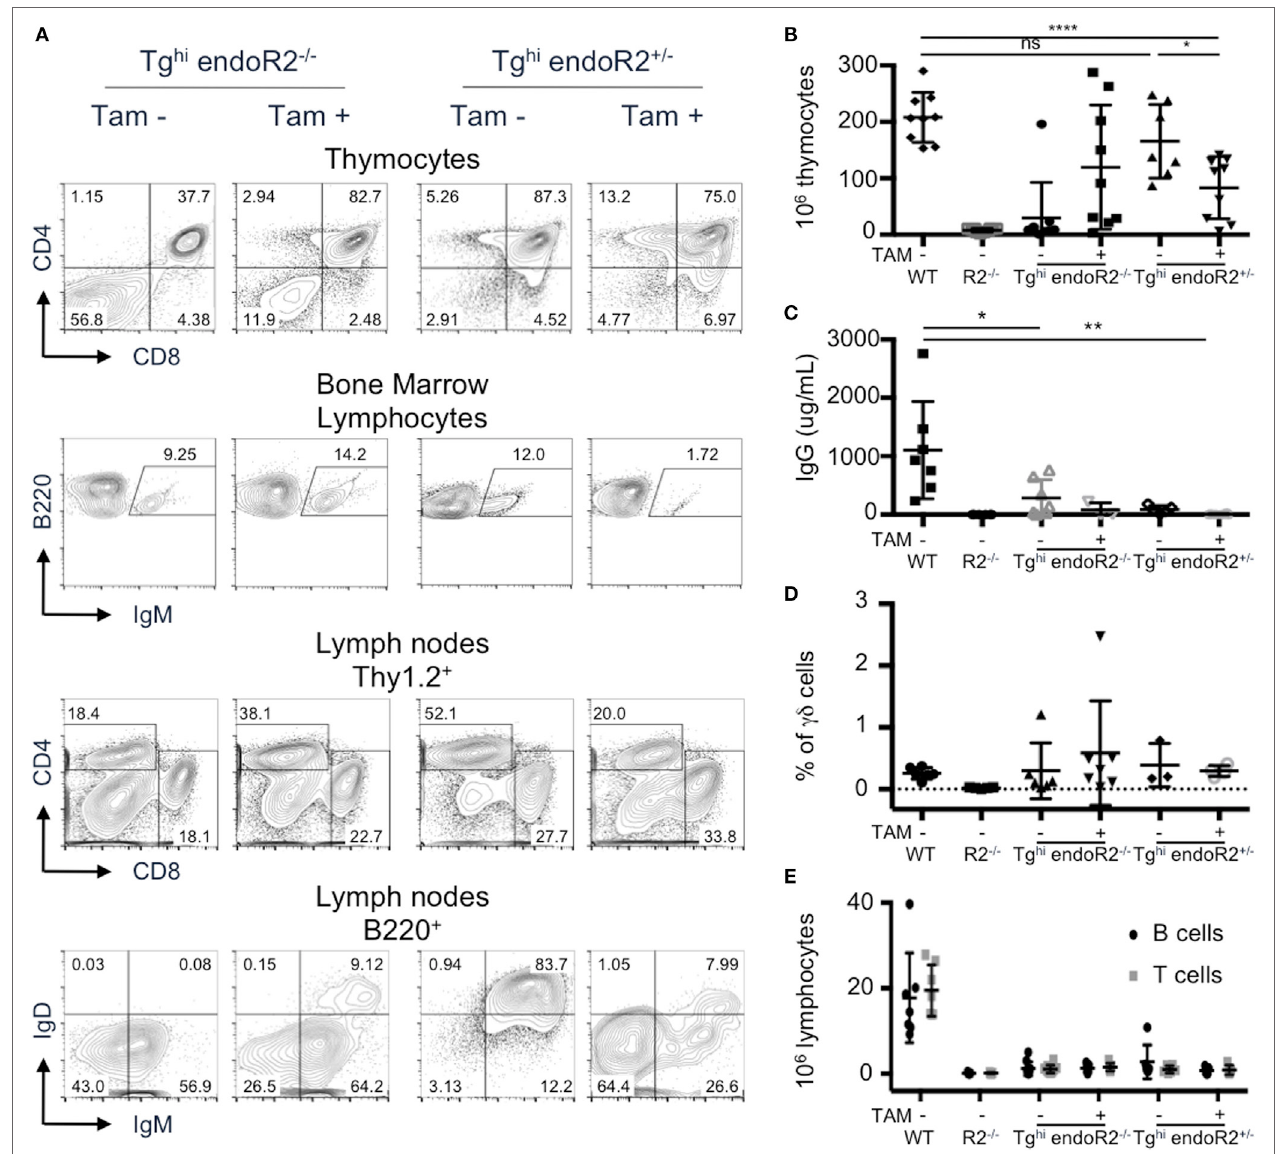
FigUre 7 | The Tg hi line is leaky and exhibits impaired lymphocyte development/maintenance. Tg hi endoR2 − / − and Tg hi endoR2 + / − mice were induced (TAM + ) or not (TAM − ) for 4 weeks before analysis. Wild-type (WT) and Rag2 − / − mice served as control (a) Representative FACS analysis of thymocytes, bone marrow, and lymph nodes in Tg hi mice. (B) Total thymocytes numbers. Tg hi endoR2 − / − TAM-mice have higher number of thymocytes than R2 − / − mice, and Tg hi endoR2 + / − mice exhibit a significant decrease of thymocytes when treated by TAM (* p = 0.016 and **** p < 0.0001 compared to untreated Tg hi endoR2 + / − and WT mice, respectively). (c) Serum IgG concentration was assessed by quantitative enzyme-linked immunosorbent assay (ELISA). Tg hi mice, whether endoR2 − / − or + / − , present significantly lower seric IgG levels than WT animals (* p = 0.03 untreated Tg hi endoR2 − / − , and ** p = 0.008 TAM + Tg hi endoR2 + / − mice, respectively). (D) Frequency of γδ T-cells in thymocytes was determined by FACS analysis. No statistical differences were found between the different groups. (e) Absolute number of mature T and B cells in pooled lymph